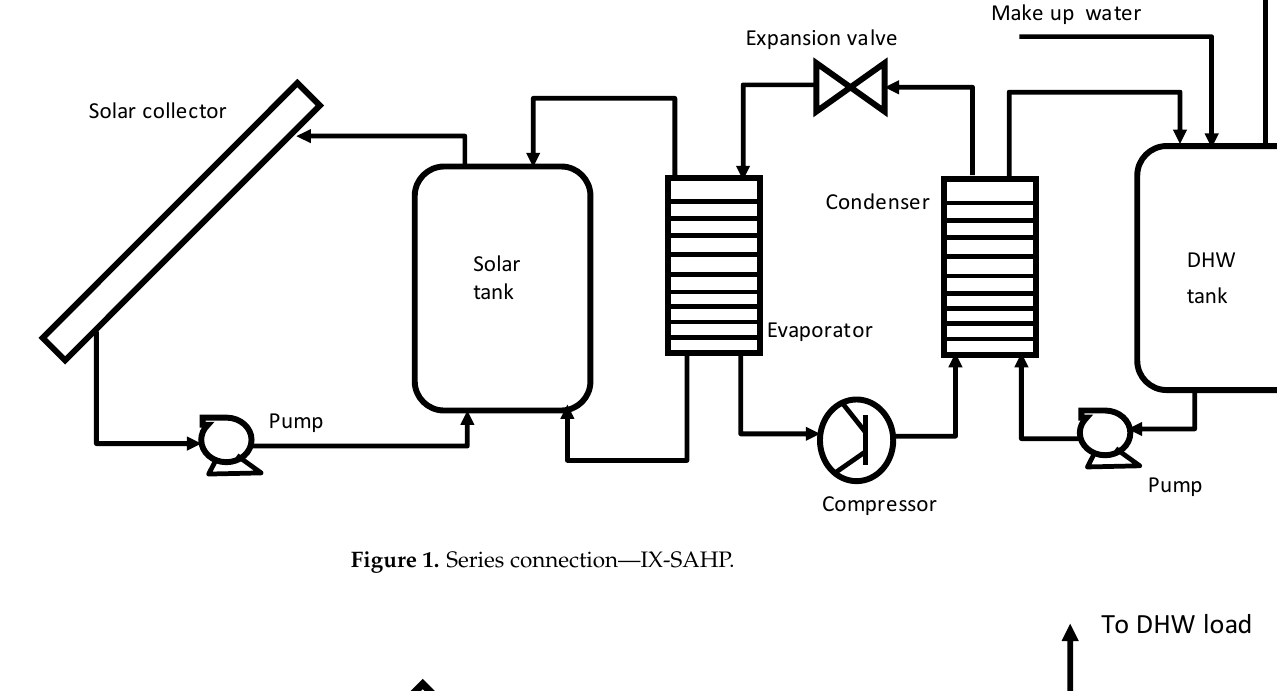
Figure 1. Series connection—IX ‐ SAHP.